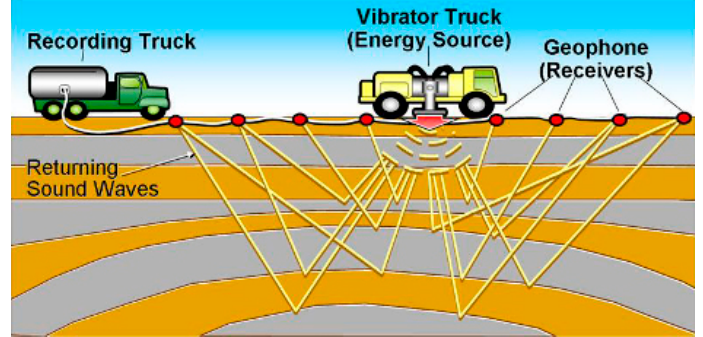
Figure 1. An illustration of the process of acquiring seismic images (source: www.petroman.co).